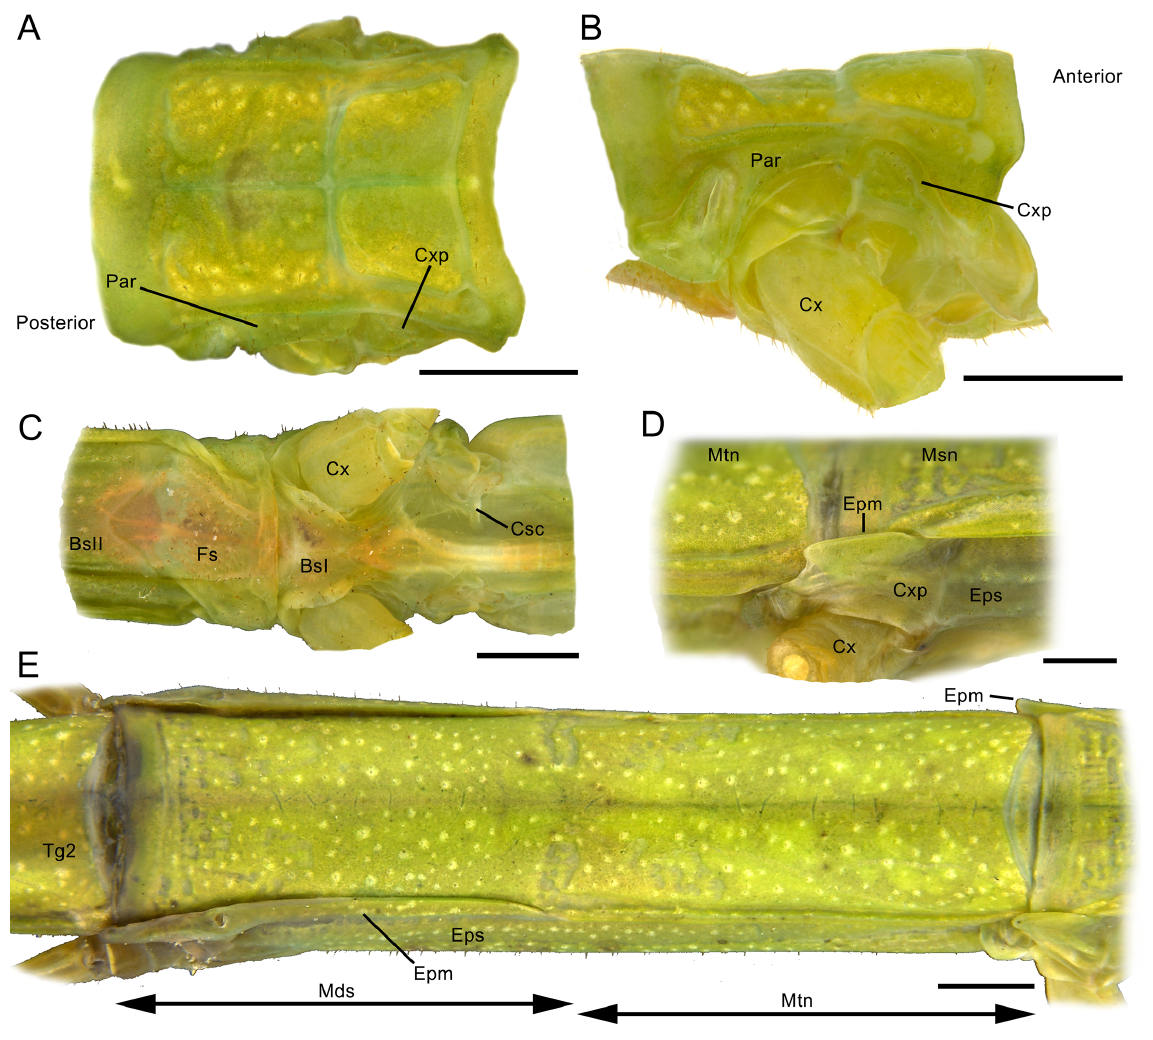
Fig. 5. Thorax morphology of Arumatia dubia (Caudell, 1904) gen. et comb. nov., adult ♀ (MZUSP V0542) from stock from Ibaté, São Paulo, Brazil. A–C . Prothorax, dorsal (A), lateral (B) and ventral (C) views. D . Detail of mesepimeron between meso- and metathorax, lateral view. E . Metathorax and median segment in dorsal view, arrows indicate the length of each segment. Abbreviations: BsI-II = pro- and mesothoracic basisterna; Csc = cervical sclerite; Cx = coxa; Cxp = coxopleurite; Epm = epimeron; Eps = episternum; Fs = prothoracic furcasternite; Mds = median segment; Msn = mesonotum; Mtn = metanotum; Par = paranotum; Tg = tergum. Scale bars: A–C, E = 1 mm; D = 0.5